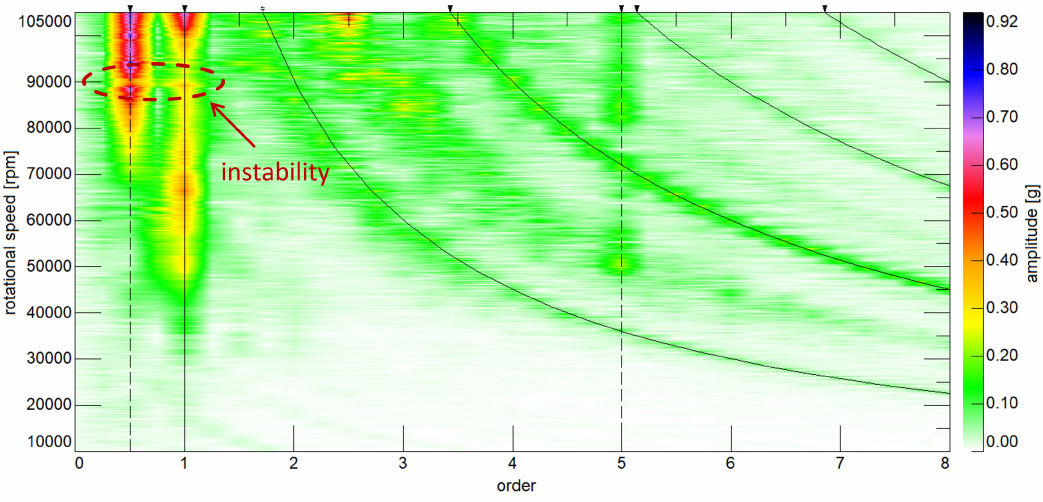
Figure 9. Dynamic characteristic of turbocharger with aluminium compressor disc presented in the form of a colourmap (speed range: from 10,000 rpm to 105,000 rpm).